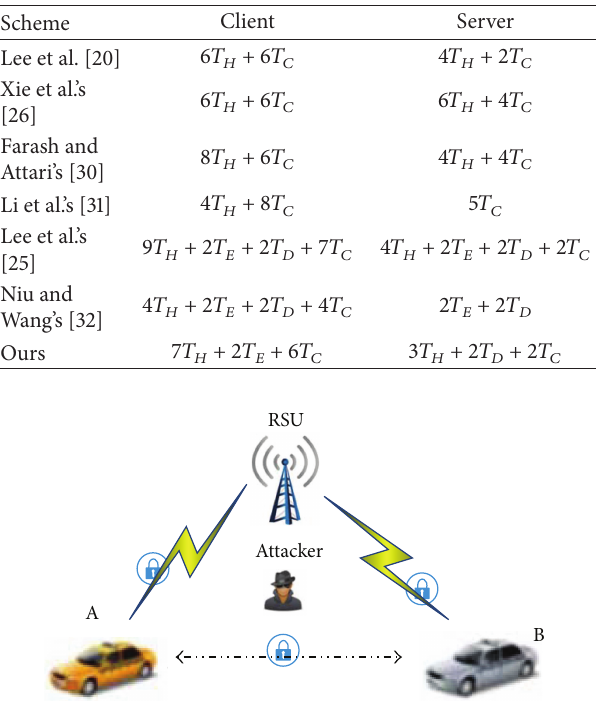
Figure 2: Authentication in